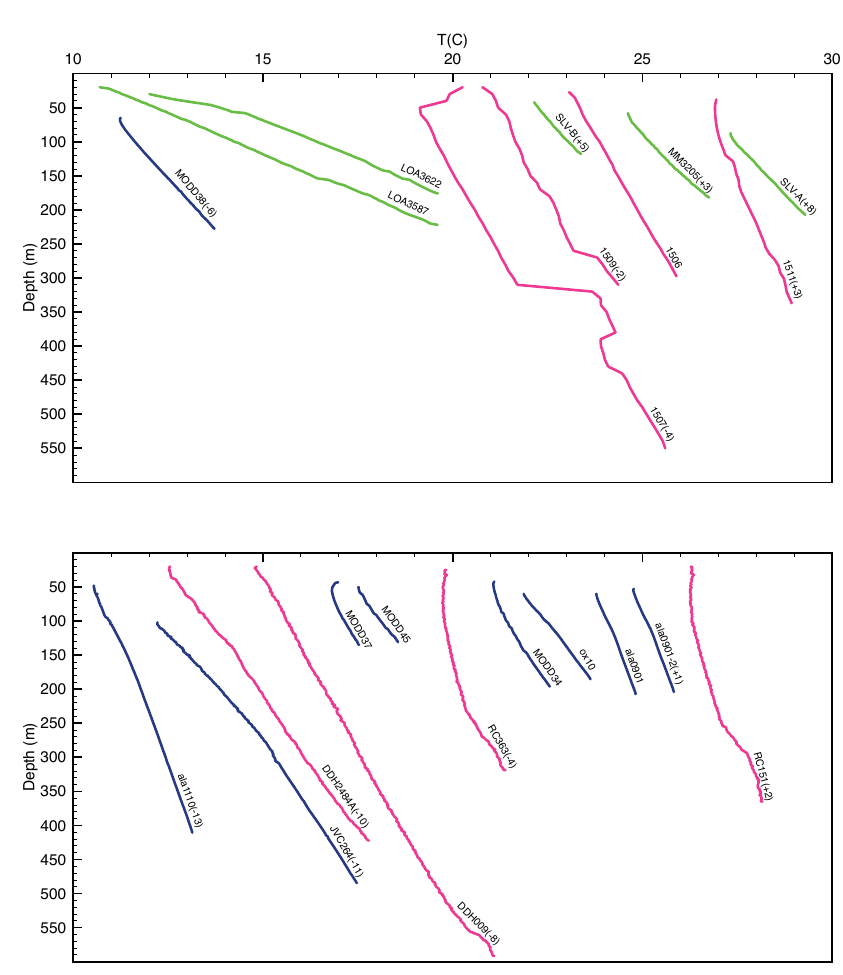
Figure A1. Rejected temperature–depth profiles measured in 1994 (green), 2012 (blue), and 2015 (pink). Temperature scale is shifted as indicated in